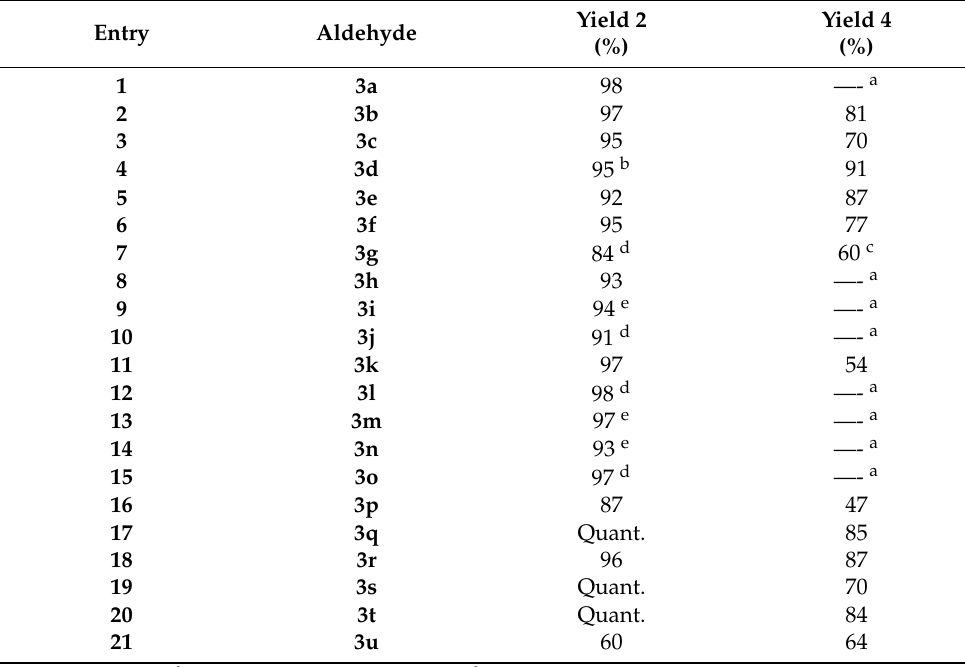
Table 1. Synthesis of bis(pyrazol-5-oles) 2 and bis(spiropyrazolone)cyclopropanes 4 .